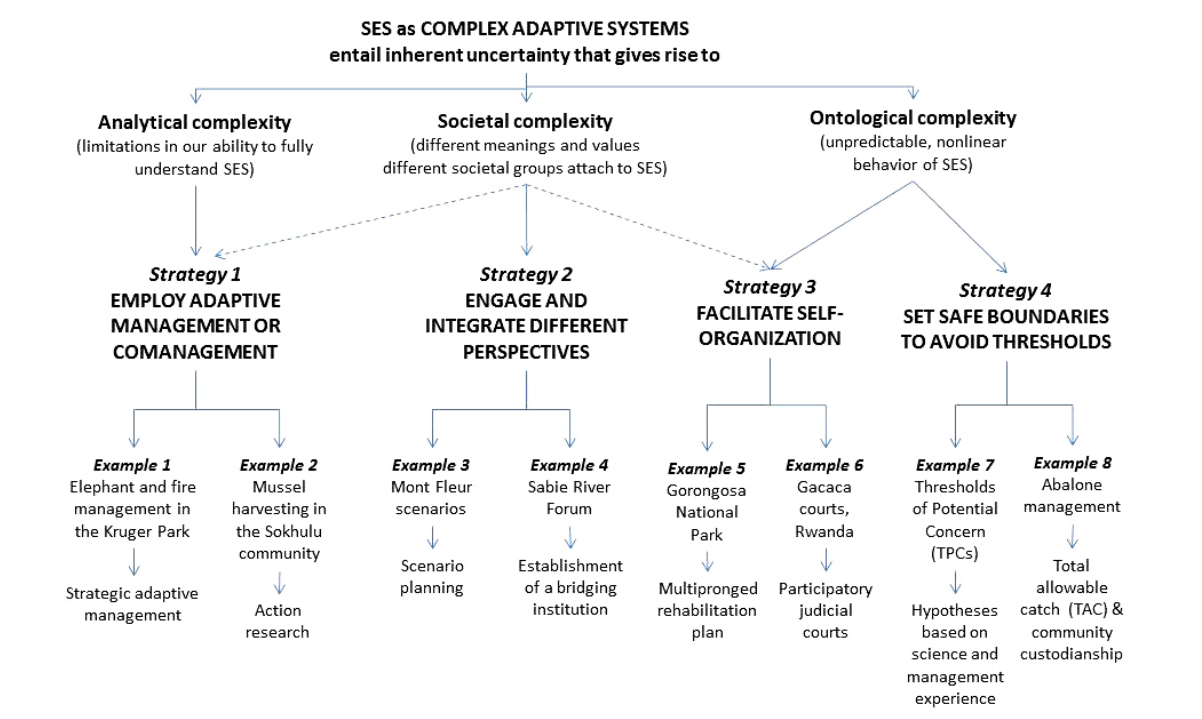
Fig. 1 . Overview of the four strategies and their respective examples discussed in this paper, showing the main type of complexity addressed by each strategy (top), and the main tool or approach used in each of the examples (bottom). Note that all strategies to some degree address all three types of complexity, and most examples contain elements of several strategies; the figure indicates only the main aspects as discussed in the